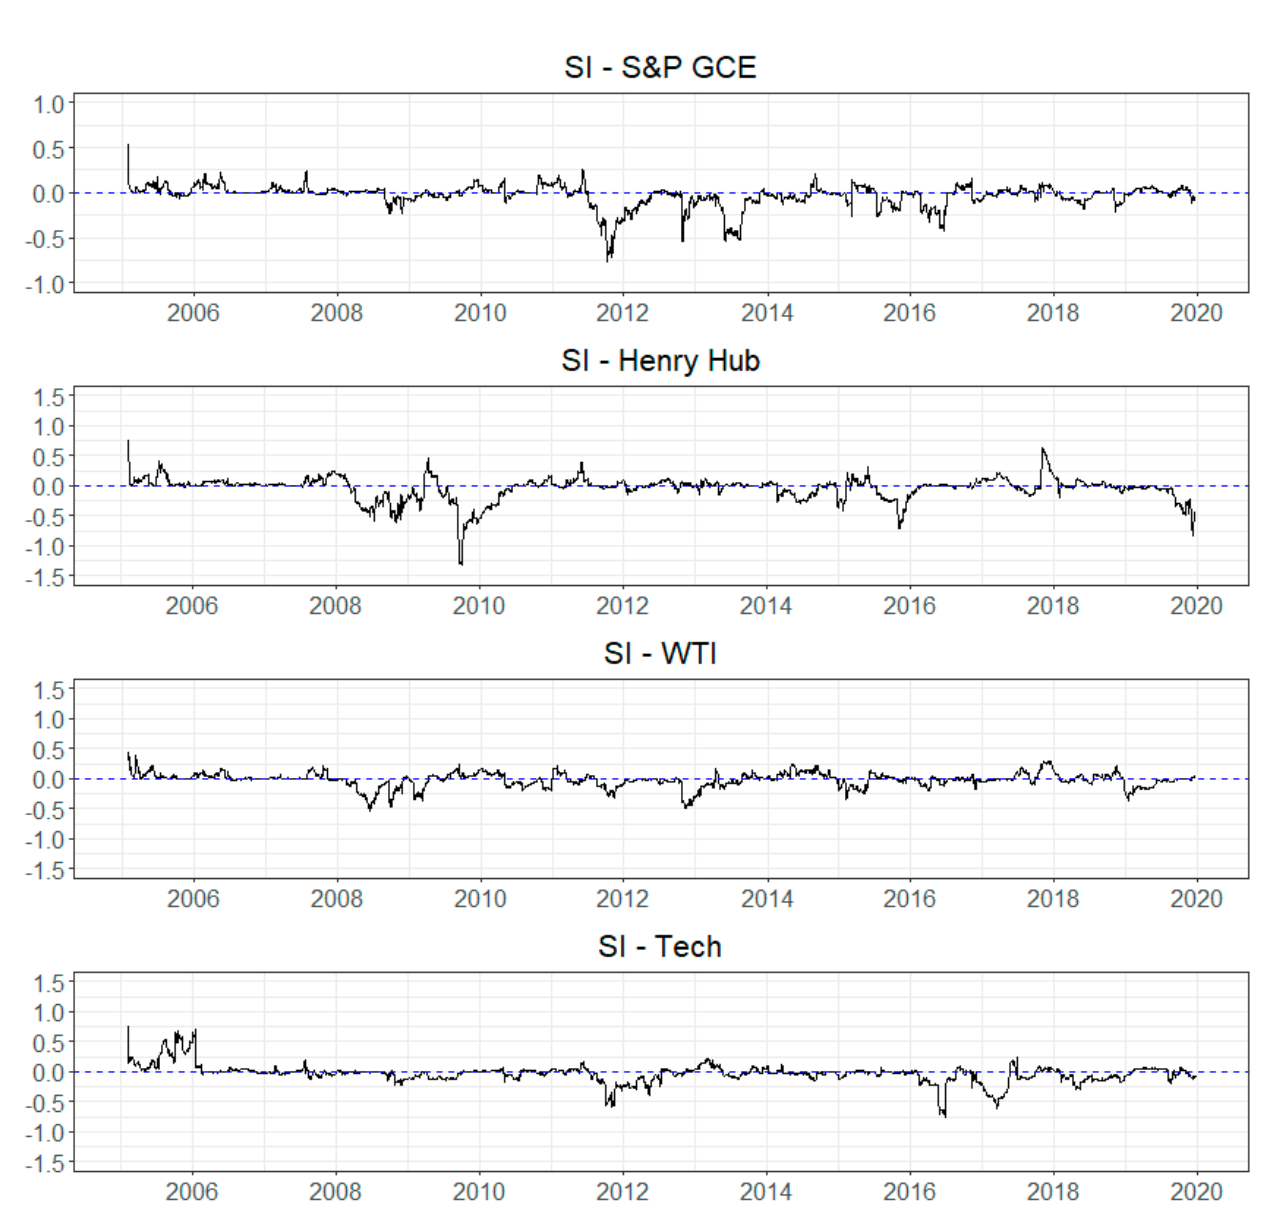
Figure A4. Dynamic net pairwise directional return connectedness (SI).